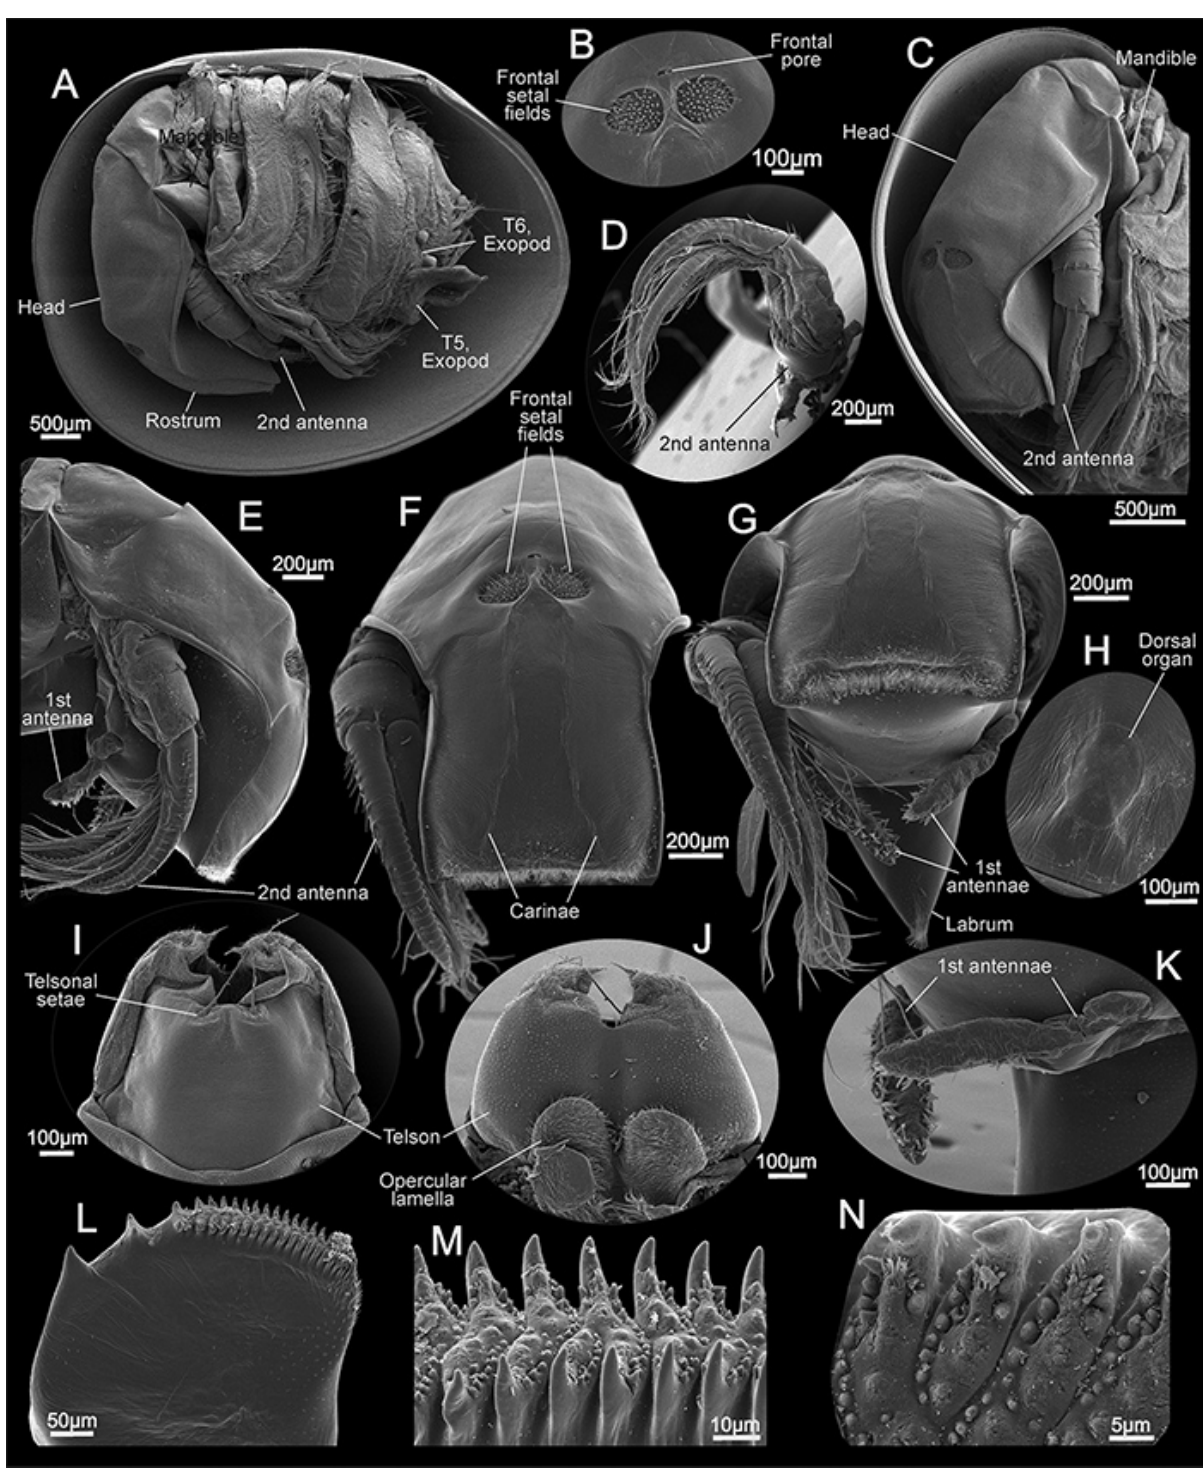
Figure 4. Lynceus grossipedia n. sp., male, scanning electron microscopy (paratype, NHMD-616086). A. Left lateral view, carapace valve removed. B. Frontal setal fields. C. Left ventrolateral view. D. Left second antenna. E. Head, lateral view. F. Head, anterior view. G. Head, anteroventral view. H. Dorsal organ. I. Telson, dorsal view. J. Telson, ventral view. K. First antennae. L. Left mandible, lateral view. M. Mandible close-up, dorsolateral view. N. Mandible close-up, dorsal